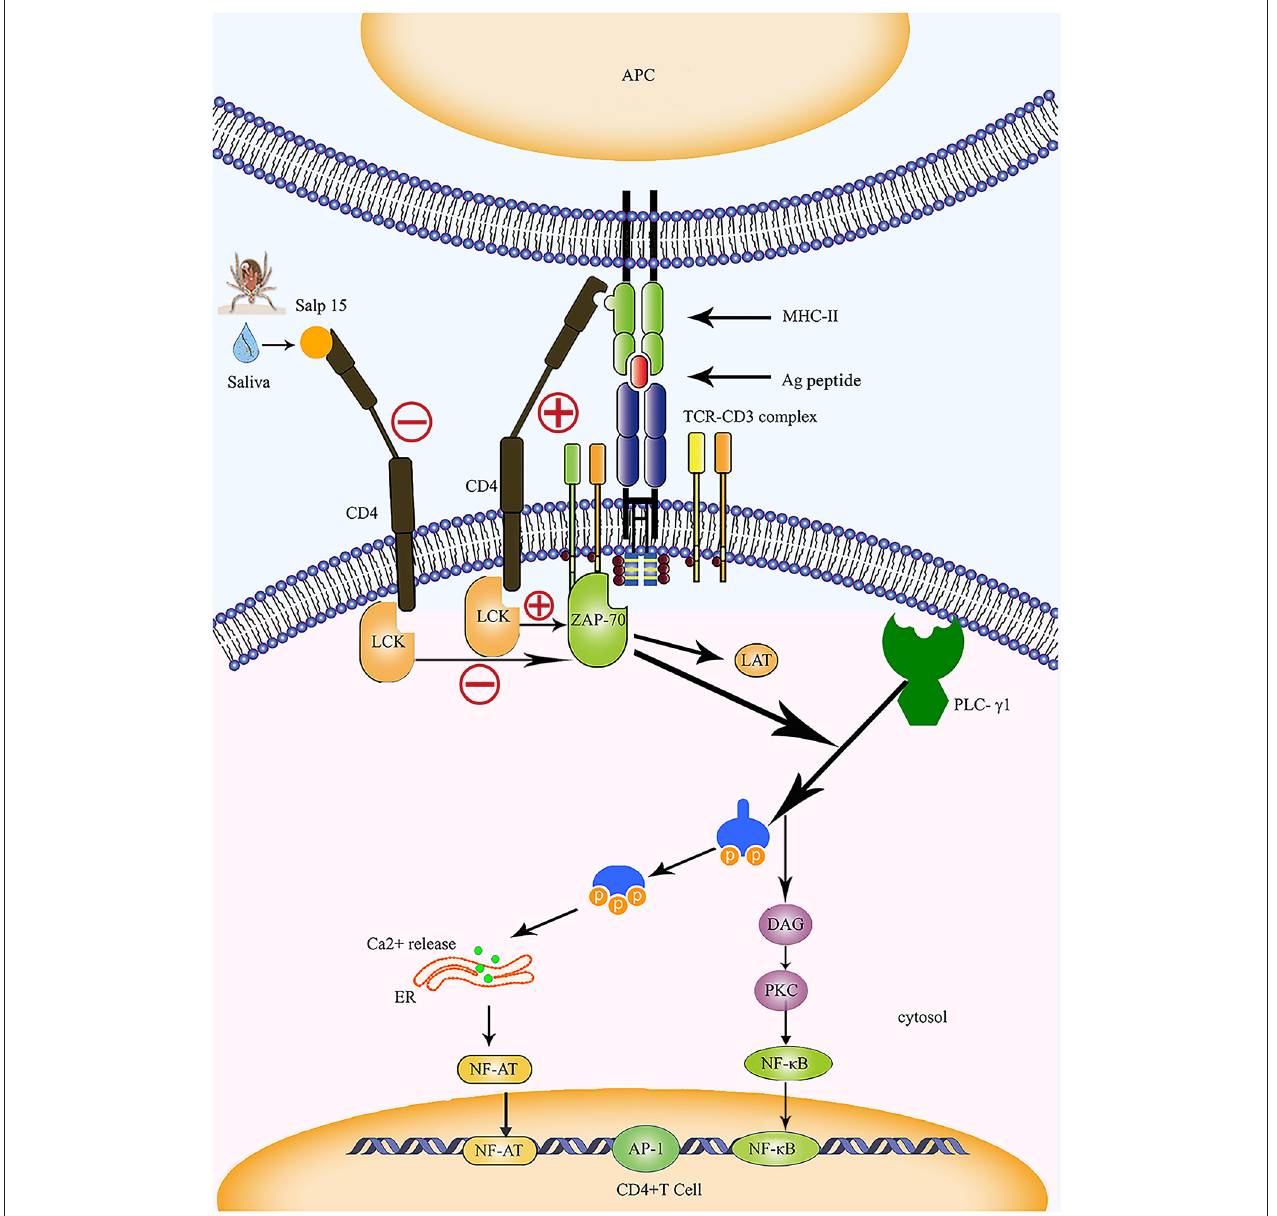
FIGURE 2 | Salp15 specifically binds to CD4 molecules on the surface of T lymphocytes, thus inhibiting TCR-mediated signal transduction. Under normal circumstances, CD4 binds to the MHC-II molecule and TCR binds to the peptide created when the TCR complex interacts with the peptide-MHC complex; this activates LCK and initiates a biochemical cascade reaction. Binding between Salp15 and CD4 can impede the activation of LCK during the activation of CD4+ T cells. During the activation of CD4+ T cells, Salp15, and CD4 binding inhibits LCK activation and prevents the activation of a series of downstream substrates, including ZAP70, LAT, and PLC- γ 1. Eventually, there is a significant reduction in the intracellular calcium flux when CD4+ T cells are activated, which reduces the binding ability of NF-AT and NF- κ B to DNA and impairs the production of IL-2. However, AP-1 transcriptional activity and other non-TCR-mediated signaling events are not affected by Salp15. ER, endoplasmic reticulum; LAT, linker of activation in T